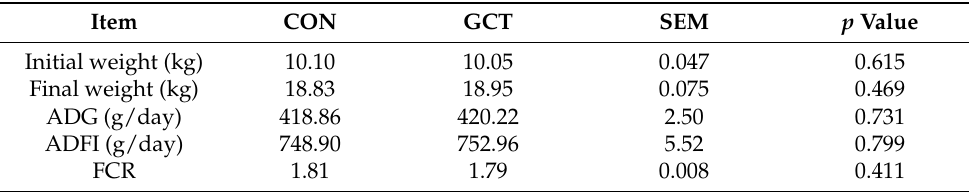
Table 2. Effect of GCT on production performance of weaned piglets.